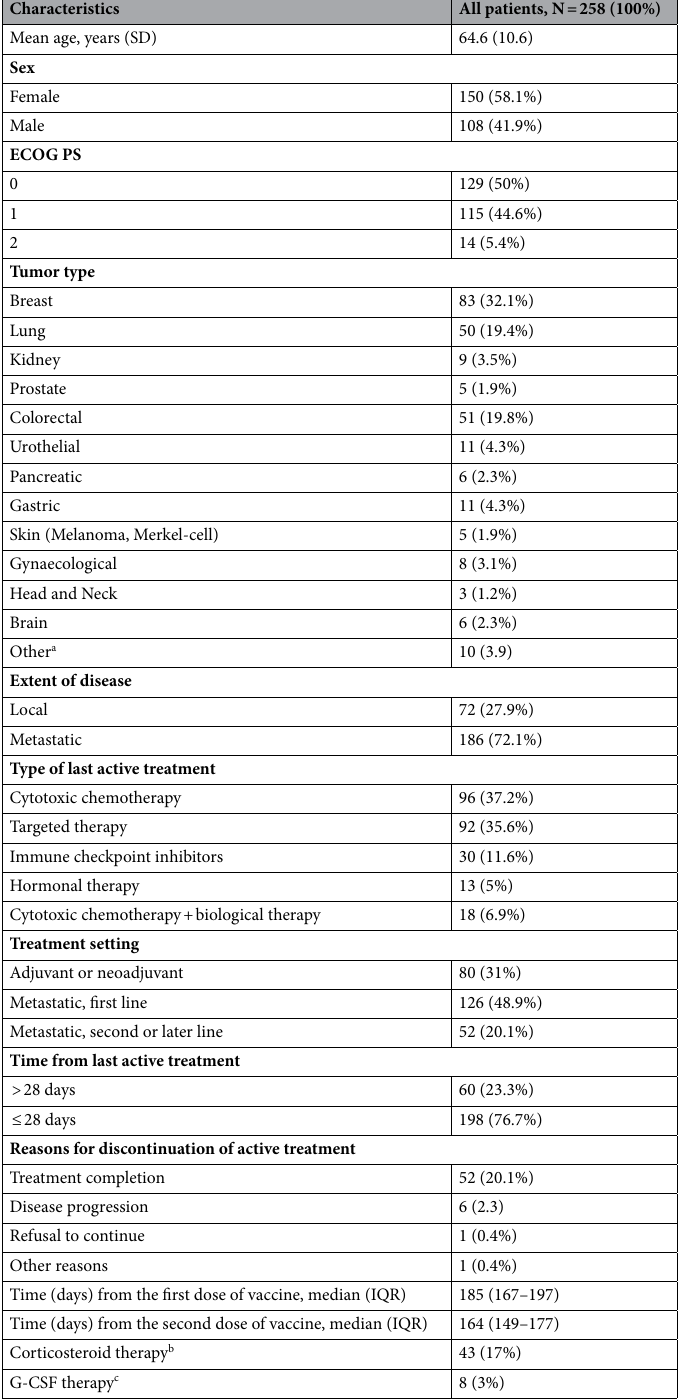
Table 1. Demographic and clinical characteristics of the study population. SD standard deviation, ECOG PS Eastern Cooperative Oncology Group Performance Status, IQR interquartile range, G-CSF granulocyte-colony stimulating factor, NA not applicable. a Other cancer types included soft-tissue sarcoma, thymoma, testicular cancer, hepatobiliary cancer, esophageal cancer, and GIST; b corticosteroid therapy indicates ≥ 10 mg per day of prednisone or equivalent for at least 7 days in the 28 days preceding third vaccine dose; c G-CSF therapy indicates administration of granulocyte colony-stimulating factor in the 28 days preceding third vaccine